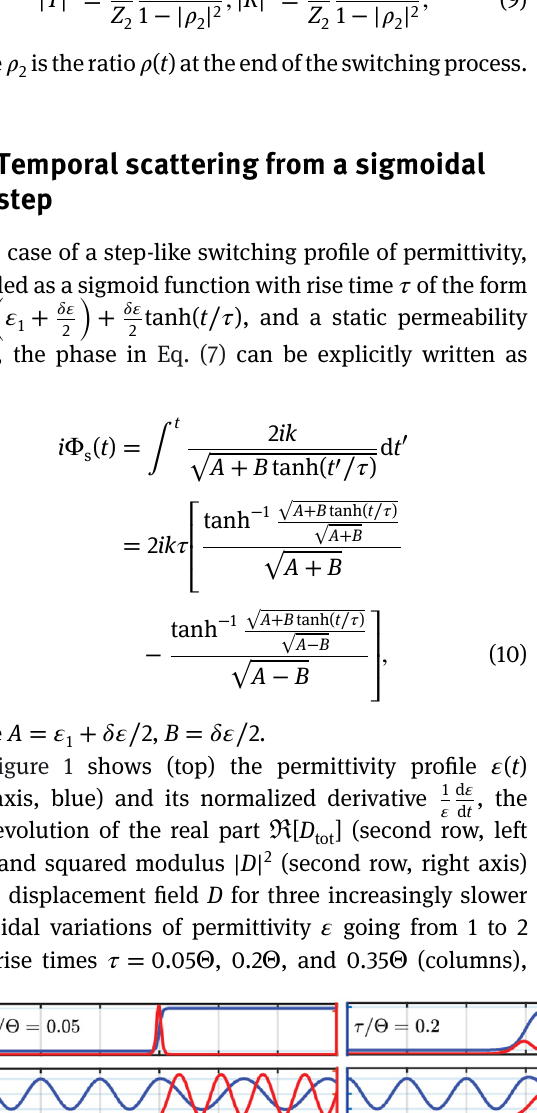
Figure 1: Top row: Permittivity profile 𝜀 ( t ) and 1 Θ = 2 𝜋 ∕ 𝜔 is the period of the incoming wave. The input frequency is 𝜔 1 modulus | D | 2 through the switching process. Third row: amplitude of the forward (blue, wave at the end of the modulation process. In order to be able to demonstrate the sharp-step case with high accuracy, the results in this figure are computed numerically using the routine in [30]. The two methods are compared in Figure